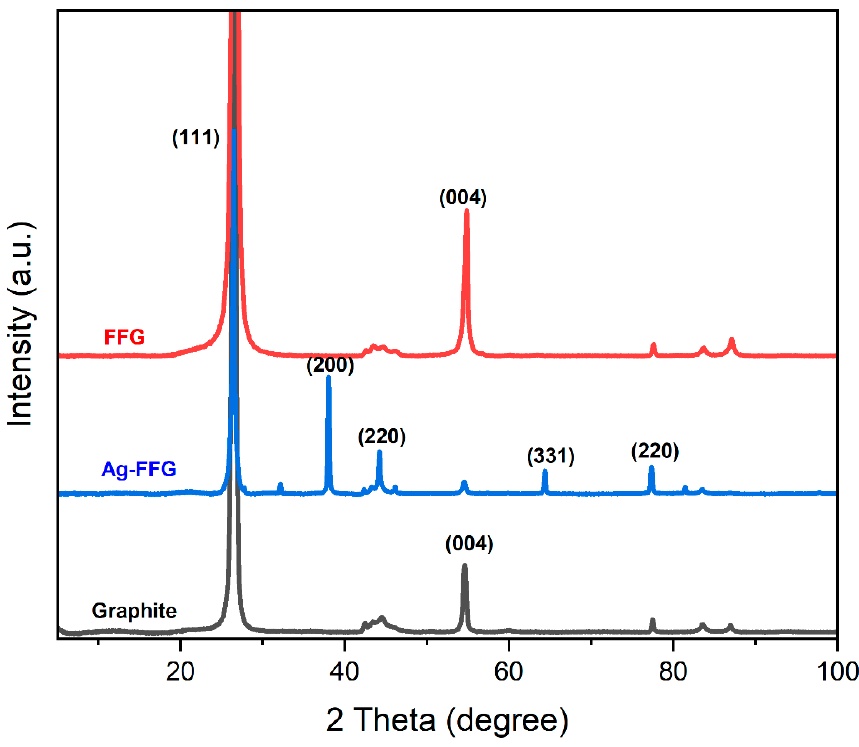
Figure 5. XRD patterns of graphite, FFG, and AgFFG.